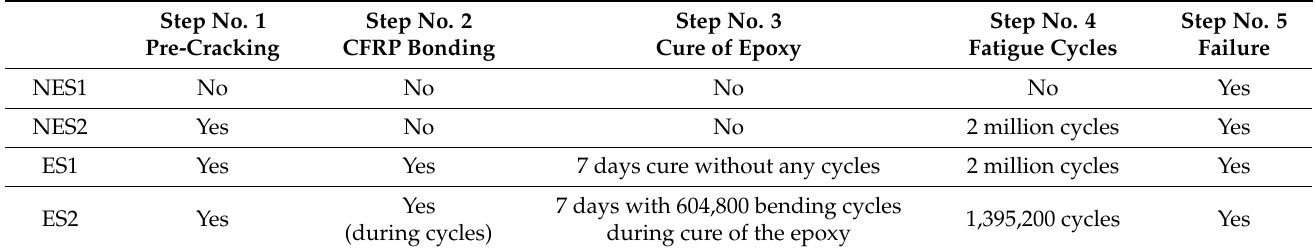
Table 4. Summary of the experimental program.